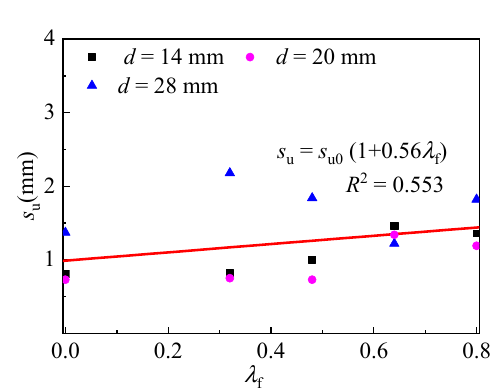
Figure 7. Relationship of s u and λ f .